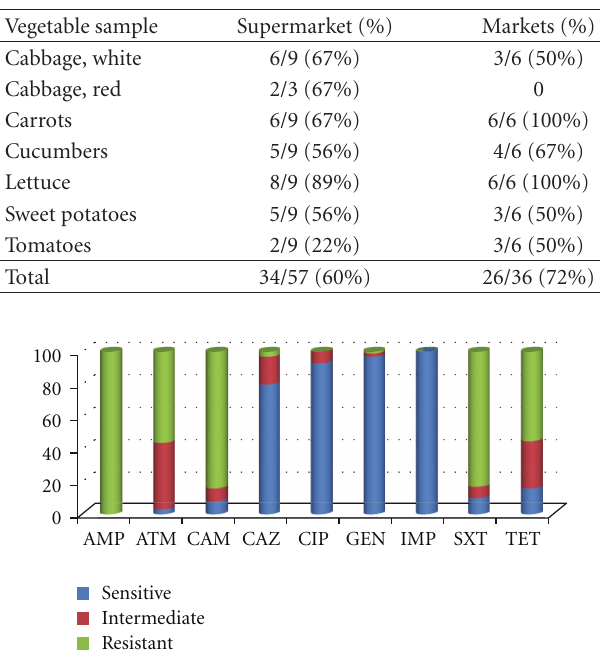
Table 2: Frequency of contamination by Pseudomonas aeruginosa of vegetable samples from supermarkets, markets, and canteens in the three regions investigated in this study.